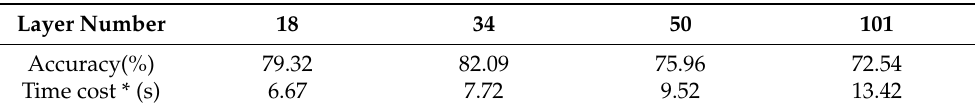
Table 6. Results of the CL–CNN model with a different number of layers with − 5 dB SNR and the sample size for each class being 55.